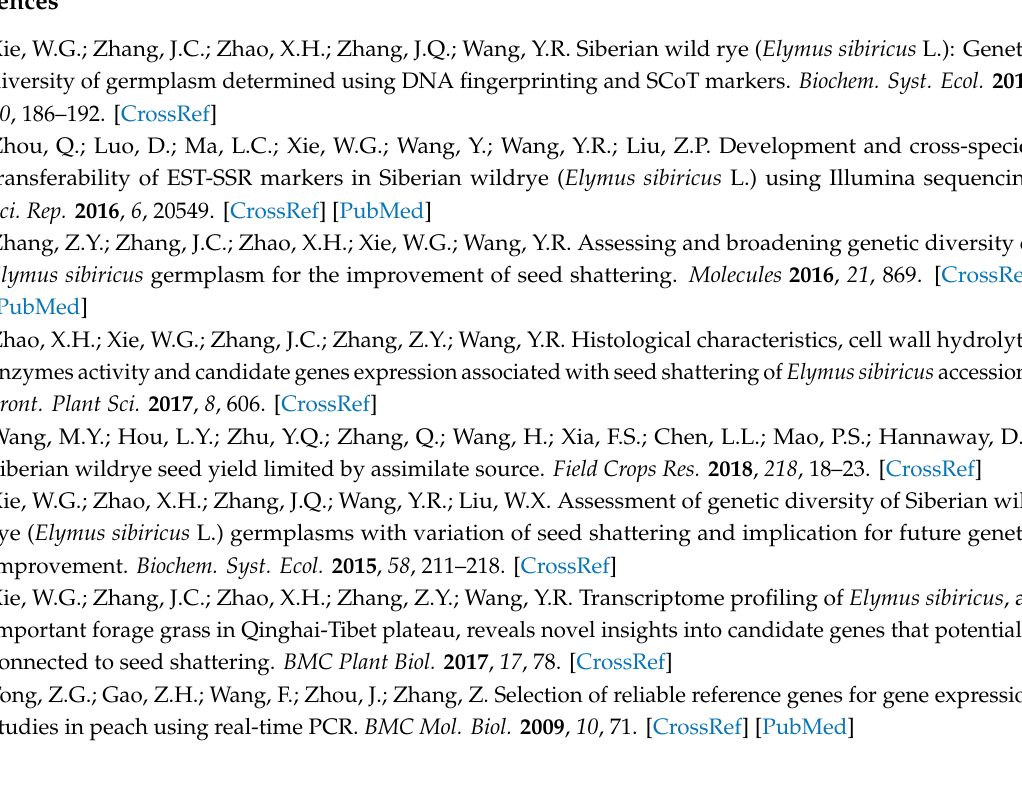
Figure S1: The top six most stable reference genes generated by delta Ct, BestKeeper, NormFinder, and geNorm. The purple, yellow, green, pink, and circles each contain the top six most stable reference genes of delta Ct, BestKeeper, NormFinder, and geNorm, respectively. The genes in the overlap area are the ones confirmed as the top six most stable reference genes by more than one algorithm. (A) Di ff erent genotypes, (B) di ff erent developmental stages, (C) di ff erent tissues, (D) salt stress, (E) heat stress, (F) cold stress, (G) osmotic stress, and (H) all samples. Figure S2: Expression stability of 13 candidate reference genes calculated by RefFinder. The lower Geomean value indicates a more stable expression. (A) Di ff erent genotypes, (B) di ff erent developmental stages, (C) di ff erent tissues, (D) salt stress, (E) heat stress, (F) cold stress, (G) osmotic stress, and (H) all